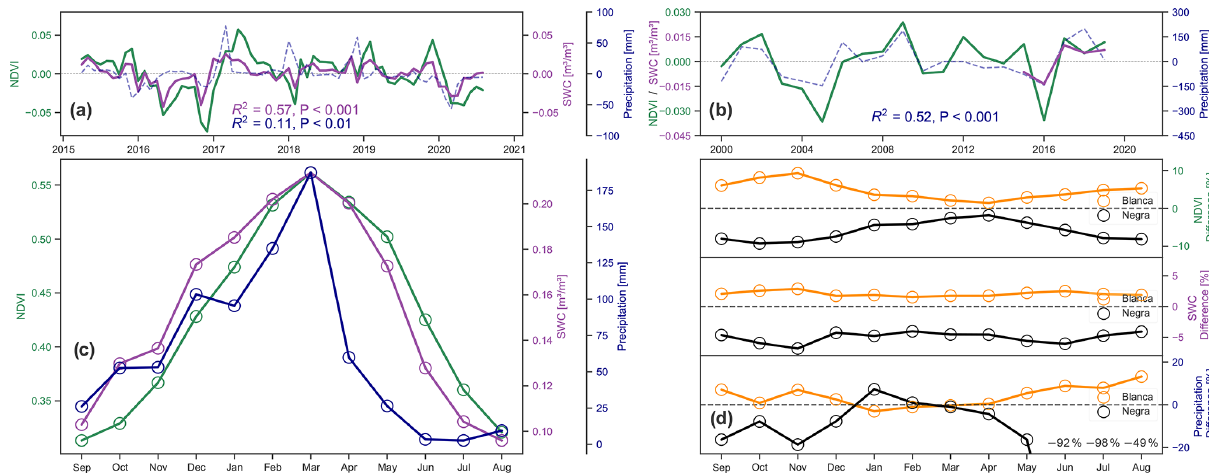
Figure 2. (a) Domain mean monthly anomalies of detrended NDVI, SMAP soil moisture and CHIRPS rainfall time series between 2015 and 2020 (for the calculation of the coefficient of determination ( R 2 ) NDVI was shifted back 1 month for CHIRPS but not for SMAP data). (b) Domain mean annual anomalies of detrended NDVI, SMAP and CHIRPS time series between 2000 and 2019 (as SMAP data are only available for 4 complete years (2015–2019), it is shown but without R 2 statistics). (c) Seasonal cycle of the whole RSB from 2015 to 2020 for NDVI, SMAP and CHIRPS data. (d) Relative differences of Cordillera Negra and Cordillera Blanca against the domain mean seasonal cycle for NDVI, SMAP and CHIRPS from 2015 to